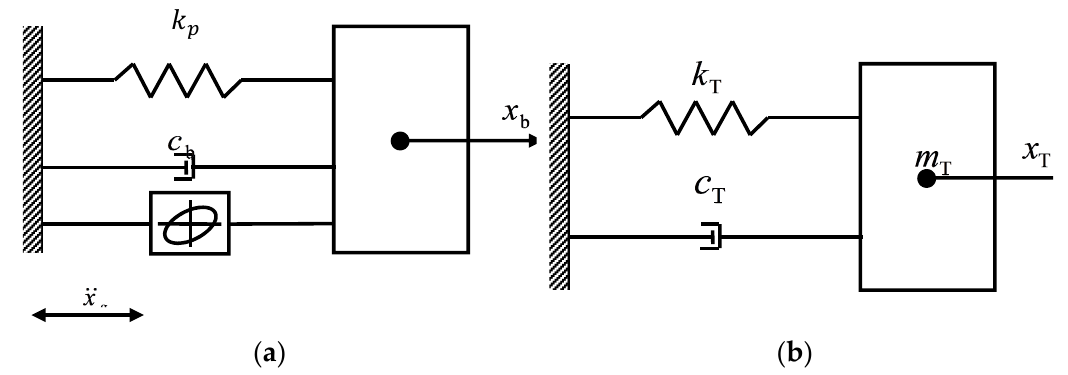
Figure 2. Schematic diagrams for ( a ) N-Z and ( b ) tuned mass dampers